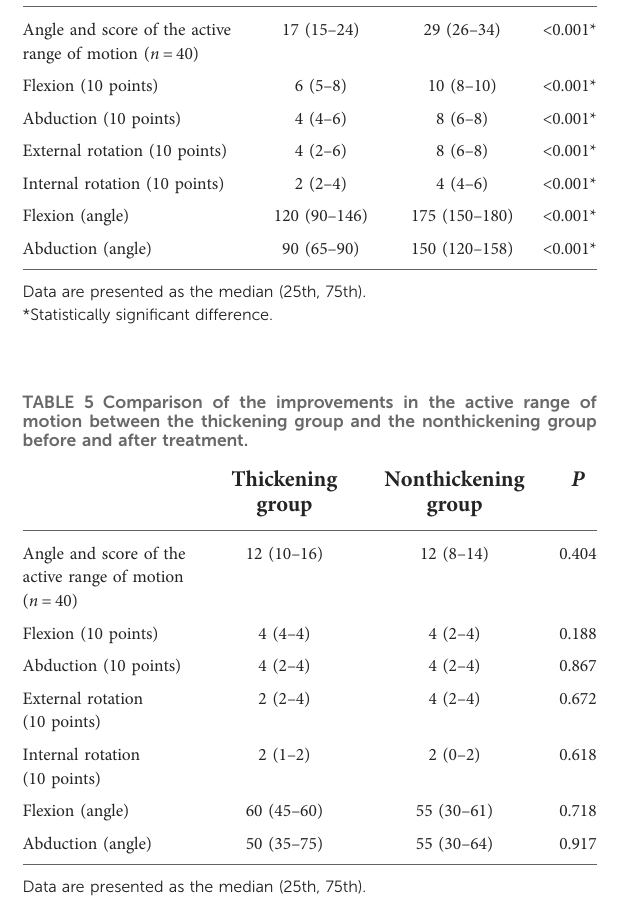
TABLE 4 Comparison of the active range of motion in the nonthickening group before and after treatment. Before